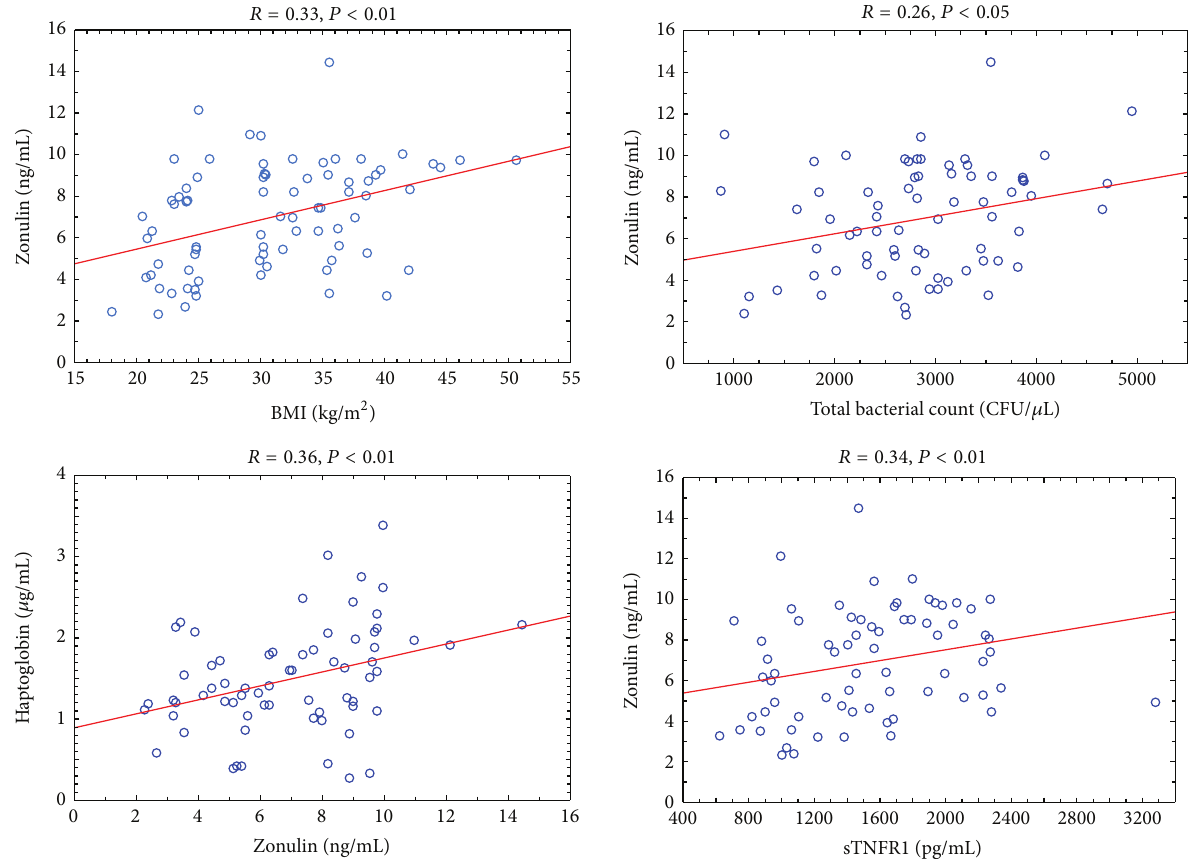
Figure 3: The correlations of zonulin and BMI, total bacterial count, haptoglobin, and sTNFR1 in all study subjects.